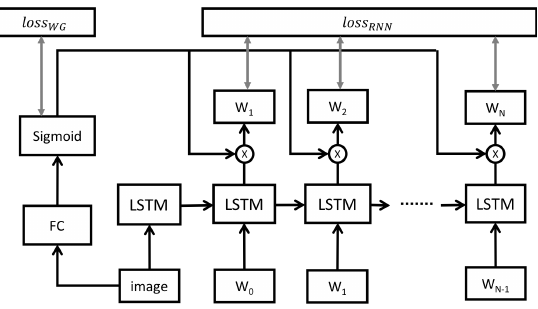
Figure 3. The structure of the word gate model. The word gate model is trained by the binary cross-entropy loss. The LSTM model is trained by the cross-entropy loss. The output of the LSTM computes with the output of the word gate to get better dictionary